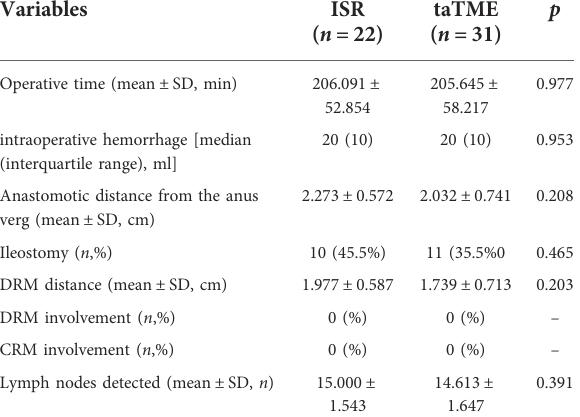
TABLE 2 Intraoperative and histopathological datas.